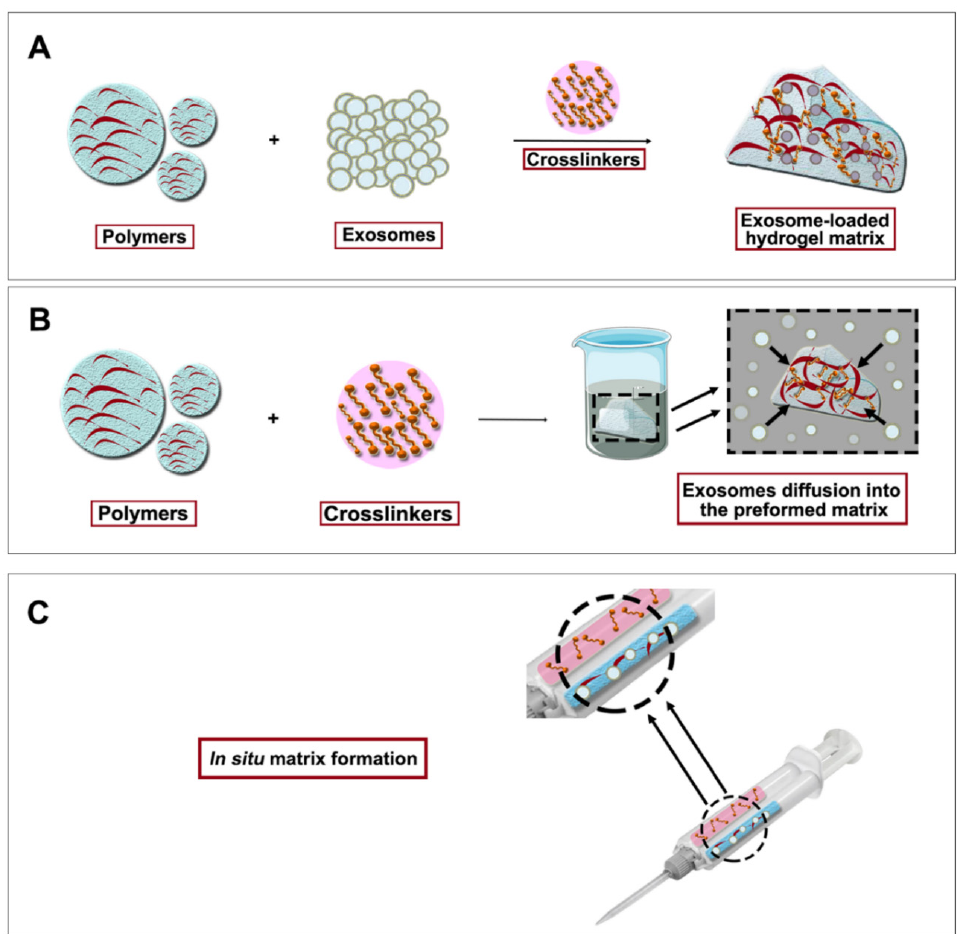
Figure 4. Exosome-loaded hydrogel formation strategies. ( A ) Exosomes are first mixed with polymers and then crosslinkation is performed. ( B ) Breathing method where hydrogel matrix is first built up and exosomes are allowed to diffuse into the matrix. ( C ) In situ matrix formation where hydrogel components and exosomes are simultaneously mixed with the use of a double syringe system.